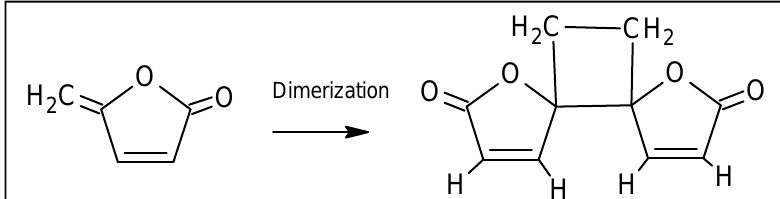
Fig. 4. The scheme of transformation of Protoanemonin into